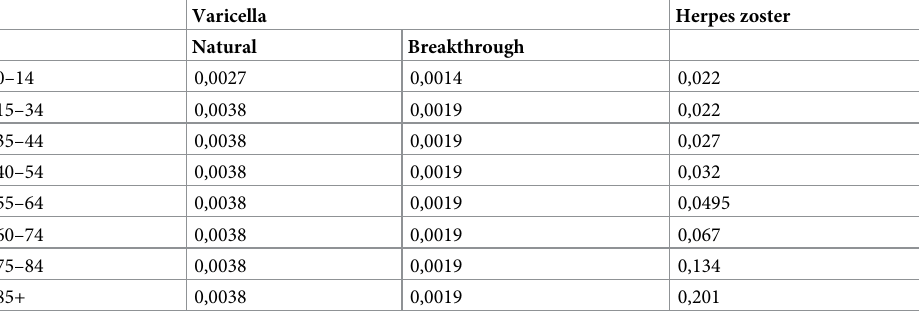
Table 3. QALY loss, dependent on disease and age group